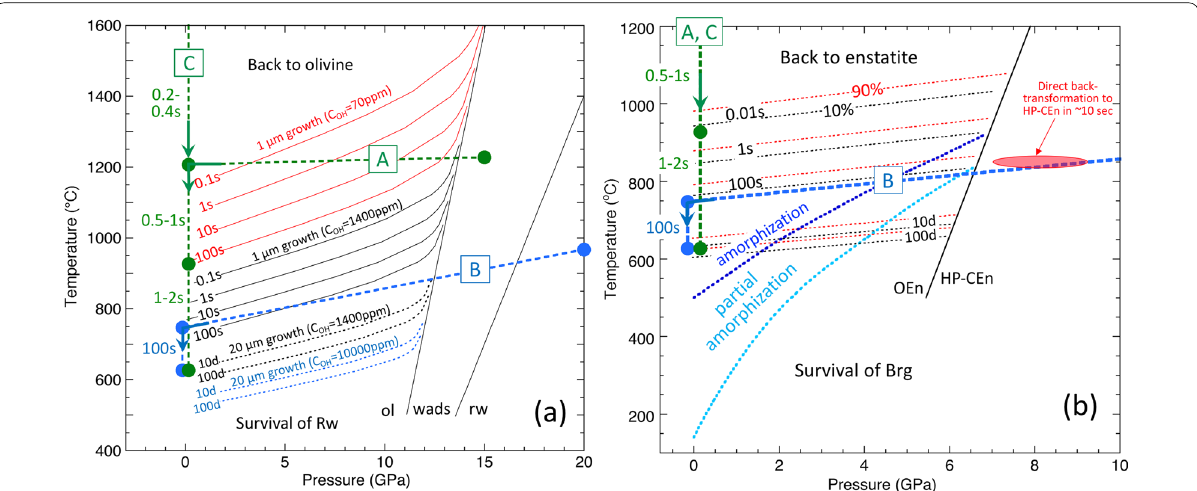
Fig. 13 Back-transformations in timescales of 0.1–100 s and 10–100 days expected in shocked meteorites and diamond inclusions, respectively. a Kinetic boundaries for the 1 µm and 20 µm growth of olivine from ringwoodite including effects of water. b Amorphization conditions in bridgmanite and kinetic boundaries for 10% and 90% crystallization of orthoenstatite from amorphous bridgmanite. Typical three thermal models (A–C) during the post-shock annealing stage are shown in bold dashed lines. (A) 20 µm inside the host with vein thickness of 0.8–1 mm, P max ~ 15 GPa and post-shock T ~ 1500 K (Hu and Sharp 2017). (B) 100 µm inside the host with vein thickness of 2 mm, P max ~ 20 GPa and post-shock T ~ 1240 K (Ohtani et al. 2004). (C) 200 µm clast in the shock vein of 0.8–1 mm thickness, P max ~ 15 GPa and post-shock T > 2000 K (Hu and Sharp